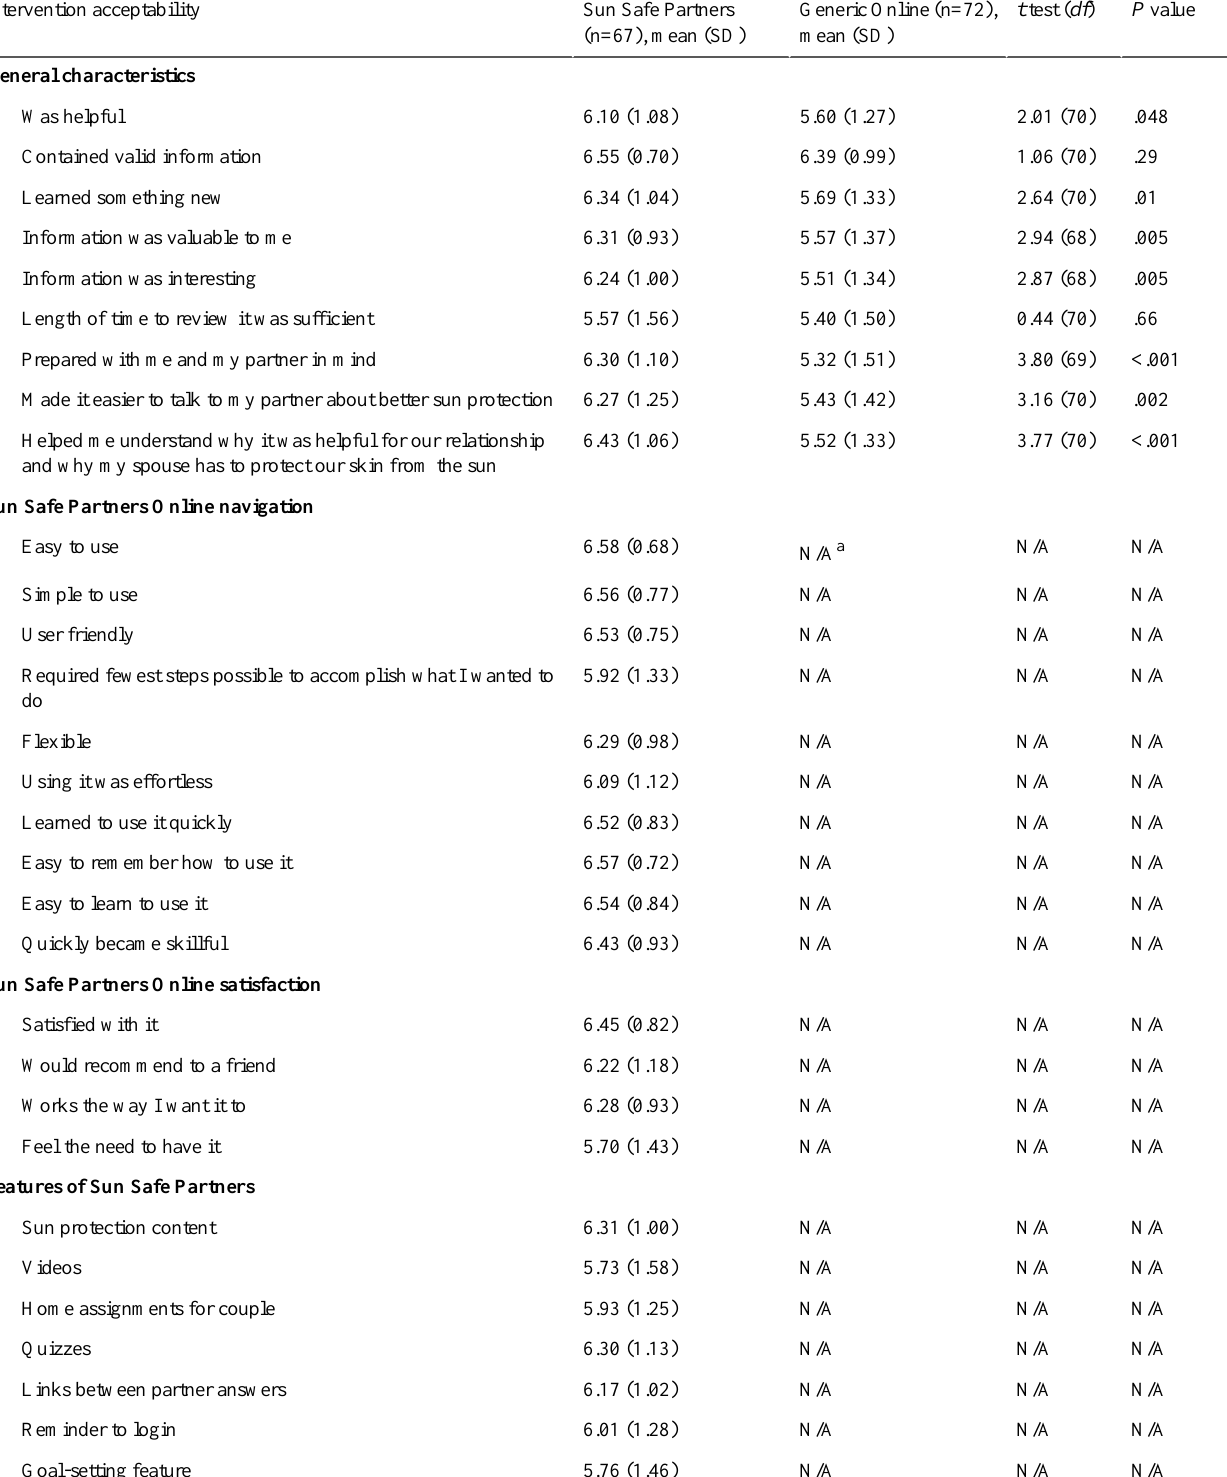
Table 4. Feasibility and acceptability of Sun Safe Partners Online and Generic Online